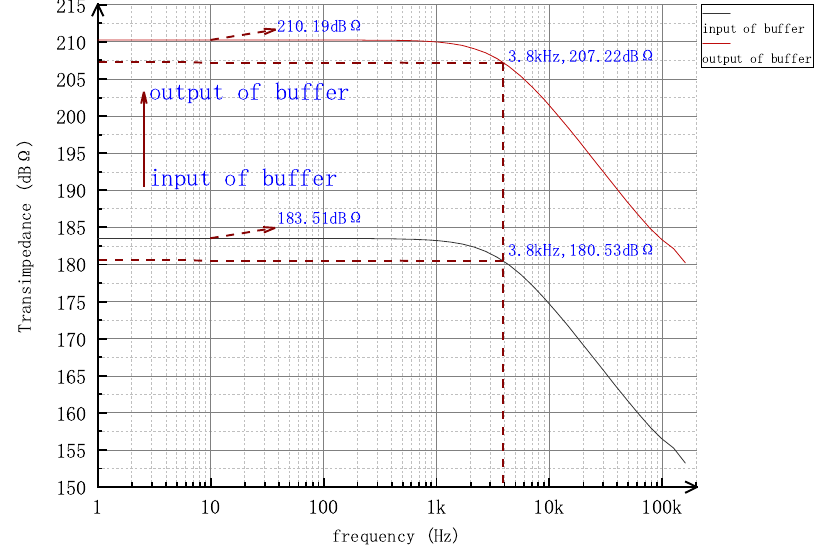
Figure 8. The comparison result of the frequency response of the input and the output of the